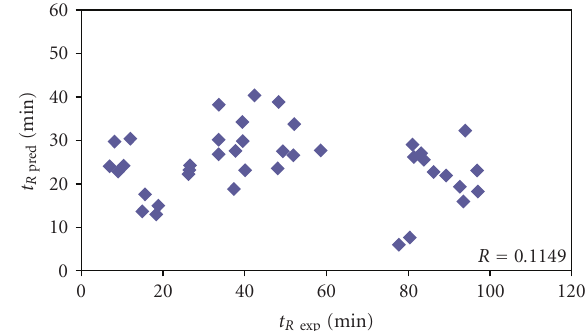
Figure 3: Correlation between experimental and predicted reten- tion times for a set of test peptides obtained from Bacillus subtilis proteome. The proteins were identified on the basis of one peptide with X corr above 1.5 ( n = 41).